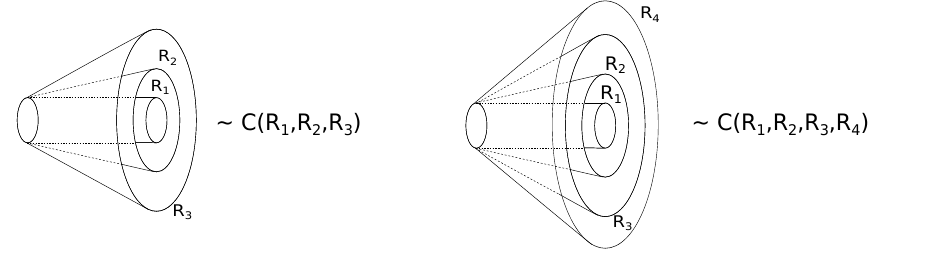
Figure 5 . S n TFT2 for Kronecker coe(cid:14)cients: central in rep basis in d = 3 (left) and d = 4 (right).